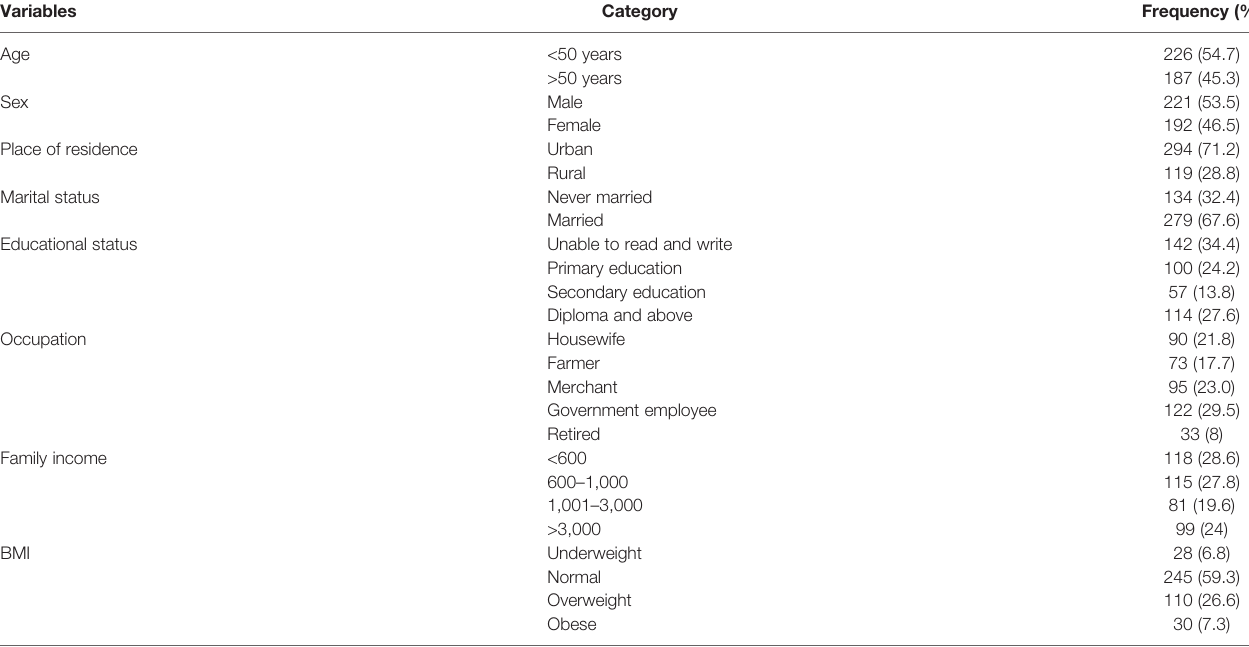
TABLE 1 | Socio-demographic characteristics of participants (N = 413).